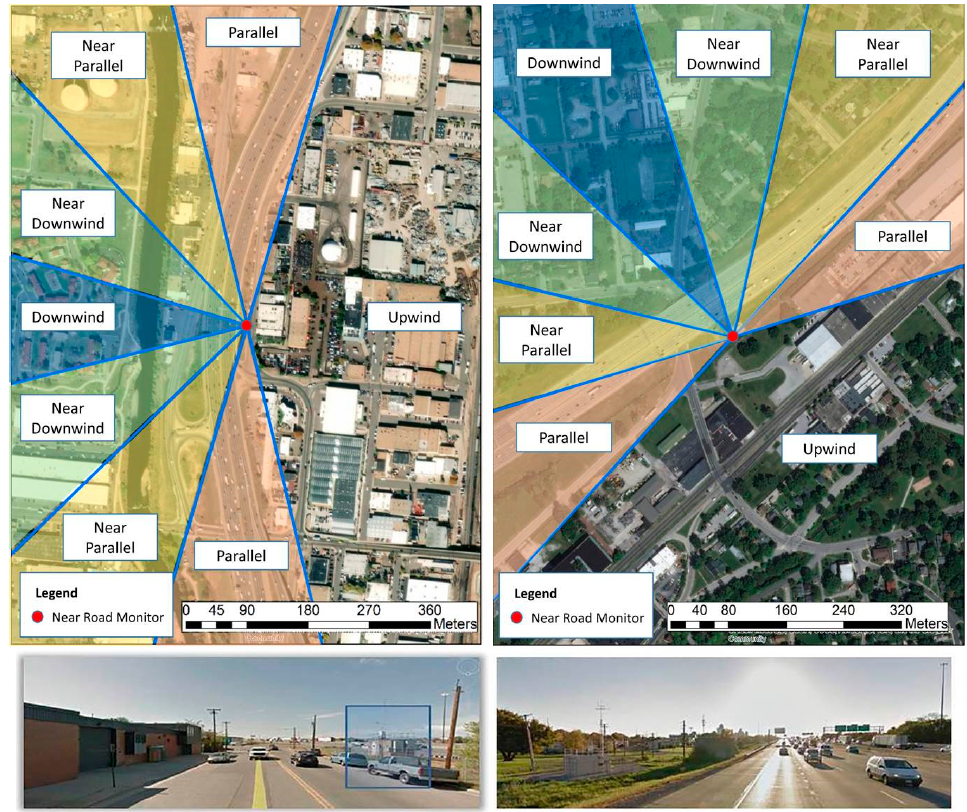
Figure 1. Satellite ( top ) and ground-level ( bottom ) views via Google Earth of the near-road sites at Denver ( left ) and Indianapolis ( right ); the Denver monitoring site is somewhat obscured by cars in the image, so the blue box denotes its location. In both satellite views, the angles used to determine wind direction bins (downwind, near downwind, near parallel, parallel and upwind) are also shown.